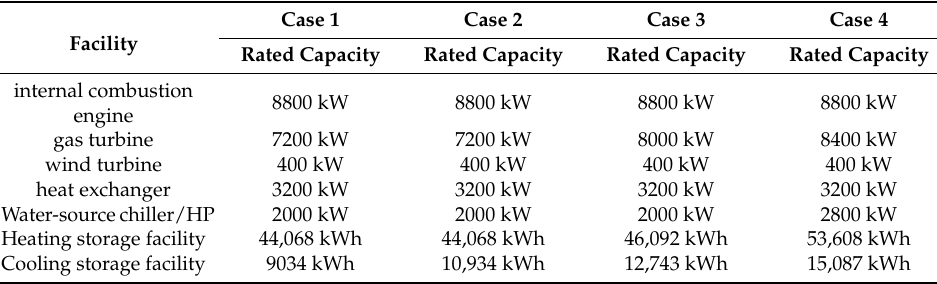
Table 5. Selection of system facilities in different cases.